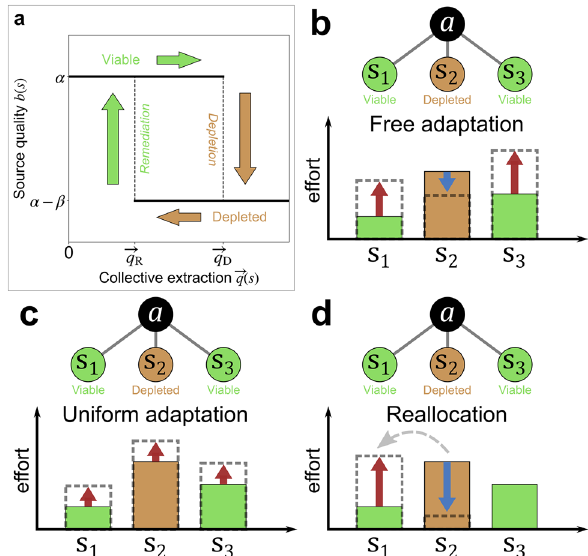
Figure 1. Evolution of resource quality and agent extraction: ( a ) Source quality exhibits bistability and hysteresis with respect to collective extraction; Illustration of three update rules. An agent a, linked to two viable sources ( s 1 and s 3 ) and one depleted source ( s 2 ) adjusts its extraction levels: ( b ) Under free adaptation , the agent increases its extraction from viable sources and decreases its extraction from depleted sources, each at rates proportional to the expected payoff increase associated with the adjustment. ( c ) Under uniform adaptation , the agent is constrained to increase (or decrease) its extraction from all sources by the same amount, at a rate that depends on the mean quality of the three sources. ( d ) Under reallocation , the agent shifts an increment of effort from a depleted source to a randomly selected viable source; the agent’s total individual extraction is